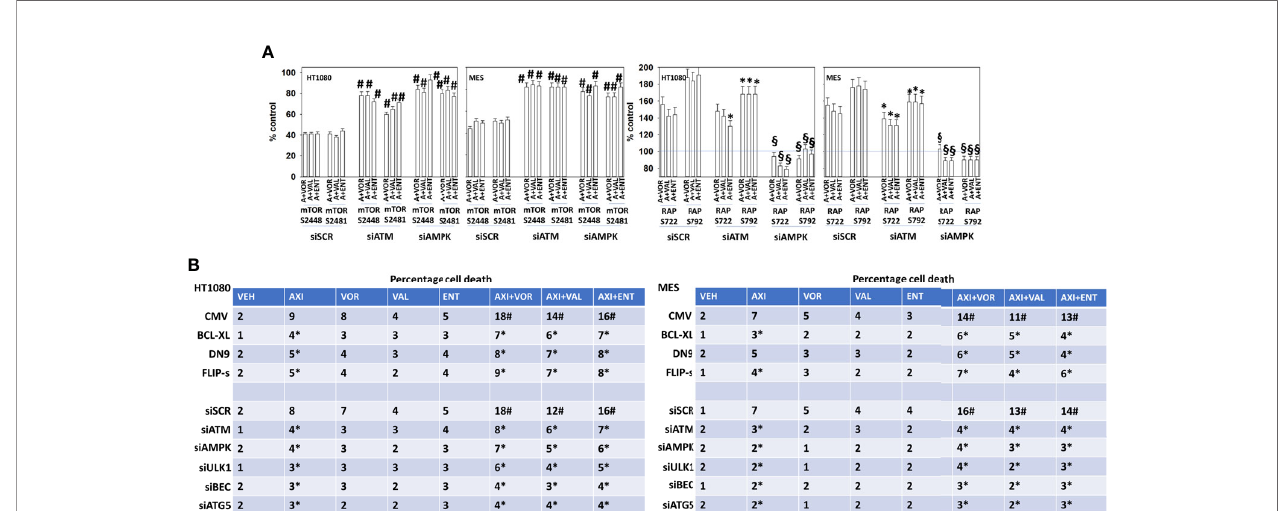
FIGURE 3 | Signaling by ATM-AMPK plays a key role in regulating both mTOR and Raptor function. (A) HT1080 and MES sarcoma cells were transfected with a scrambled control siRNA (siSCR) or with validated siRNA molecules to knock down the expression of either ATM or AMPK a . Twenty-four h after transfection, cells were treated with vehicle control, [axitinib (50 nM) + entinostat (50 nM)], [axitinib (50 nM) + vorinostat (500 nM)], [axitinib (50 nM) + sodium valproate (250 m M)] in combination as indicated in the graphical panels for 6h. Cells were fi xed in place and in-cell immunoblotting performed to determine the total protein levels of mTOR and Raptor, and the phosphorylation of mTOR S2448, mTOR S2481, Raptor S722 and Raptor S792. The percentage phosphorylation is plotted for each site corrected for total protein loading with vehicle control of each transfection being de fi ned as 100% (n = 3 +/-SD). # p < 0.05 greater than corresponding value in siSCR control; *p < 0.05 less than corresponding value in siSCR cells; § p < 0.05 less than corresponding value in siATM cells. (B) Sarcoma cells were either transfected with an empty vector plasmid (CMV) or with plasmids to express BCL-XL, c-FLIP-s or dominant negative caspase 9; or were transfected with a scrambled siRNA control or with validated siRNA molecules to knock down the expression of ATM, AMPK a , ULK1, ATG5 and Beclin1. Twenty-four h after transfection, cells were treated with vehicle control, axitinib (50 nM), entinostat (50 nM), vorinostat (500 nM), sodium valproate (250 m M) alone or in combination as indicated in the graphical panels. Twenty-four h later, cells were isolated, and viability determined by trypan exclusion assays in triplicate (n = 3 +/-SD). Data are rounded to the nearest whole number. *p < 0.05 less than corresponding value in siSCR/CMV transfected